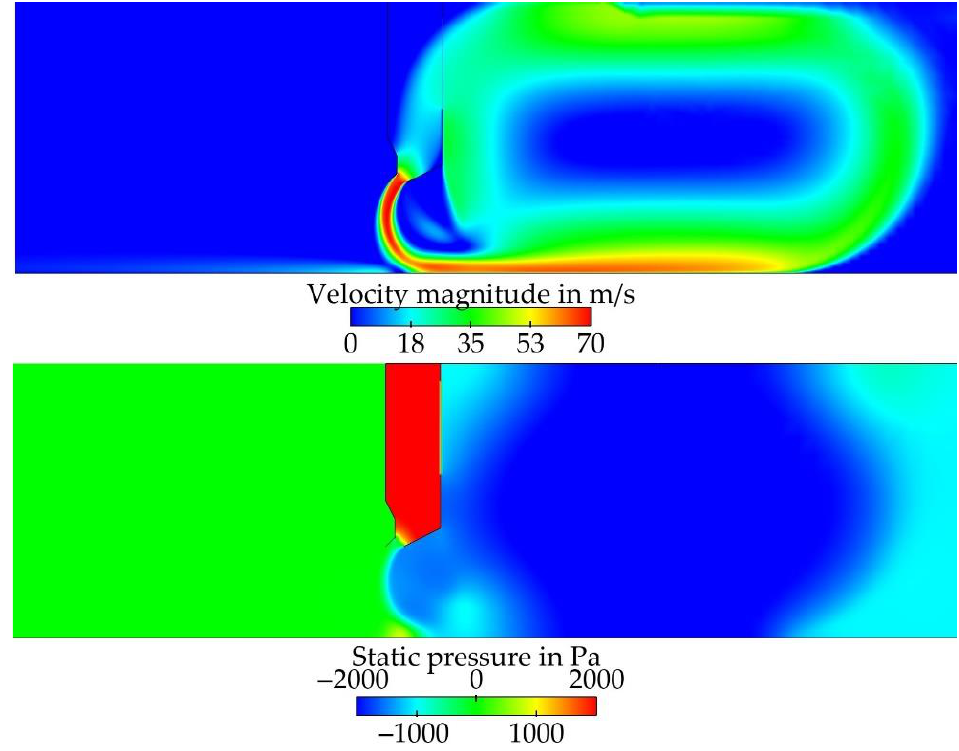
Figure 7. Velocity and pressure contours in the curtain-only variant, for curtain fan Δ p = 3000 Pa.